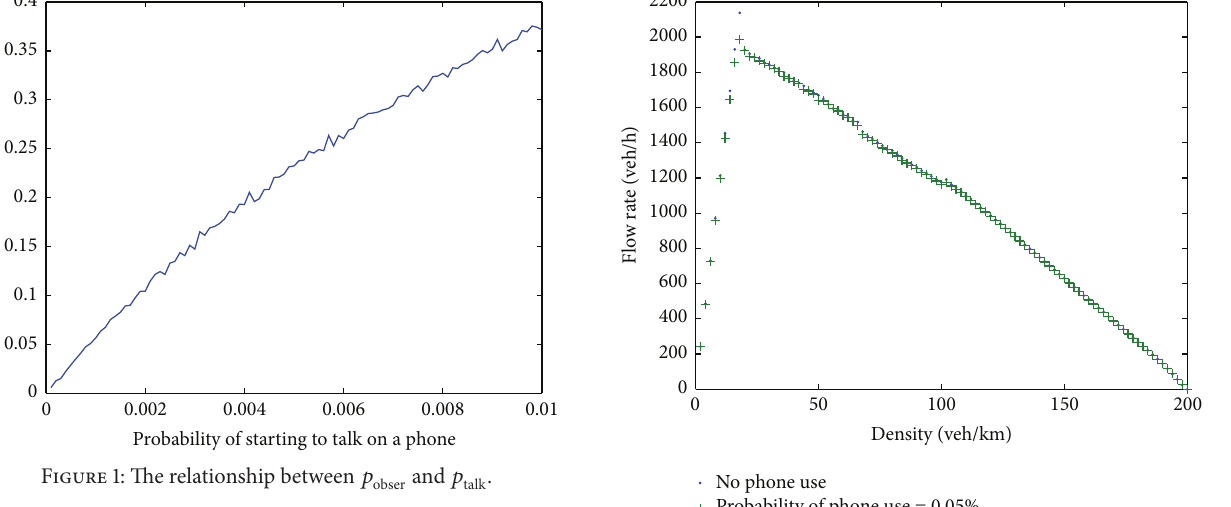
and 𝑝 . obser talk